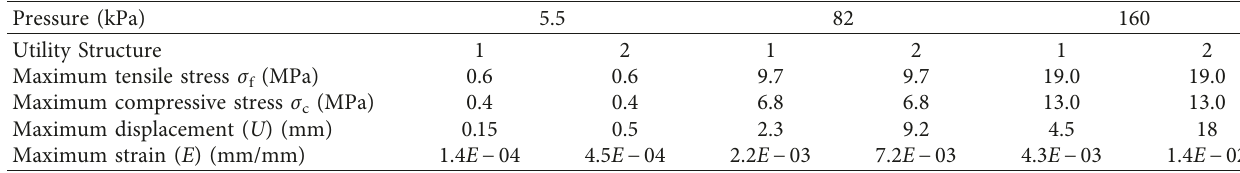
Table 6: Simulation results for Utility Structure 1 and Utility Structure 2 with a wall thickness of 25mm as a function of soil pressure. Pressure (kPa) Utility Structure Maximum tensile stress σ f (MPa) Maximum compressive stress σ c